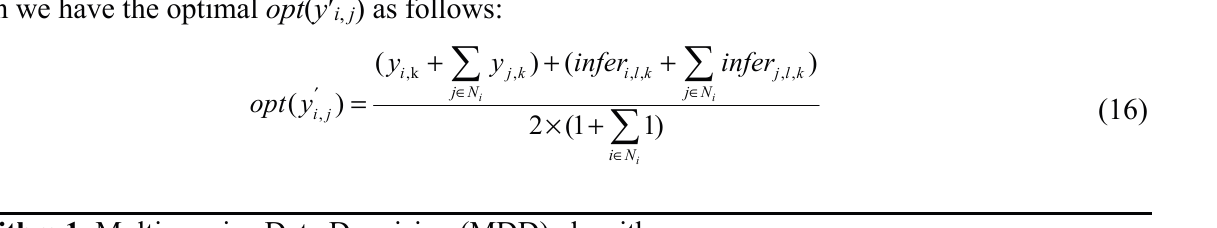
Algorithm 1. Multi-service Data Denoising (MDD)